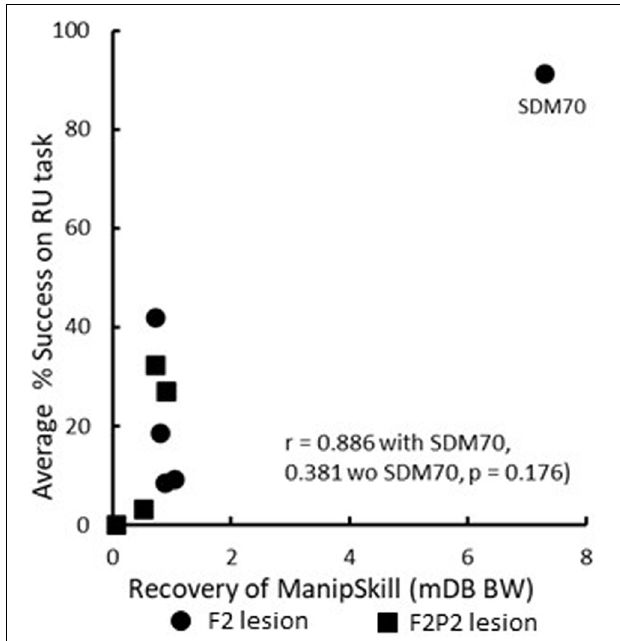
FIGURE 7 | Scattergraph showing the relationship between highest percentage use of the contralesional hand in a single RU test and recovery of manipulation skill in the mMAP curved rod (CR) task. Each plotted point is for a single monkey. All nine monkeys were included in this figure and correlation